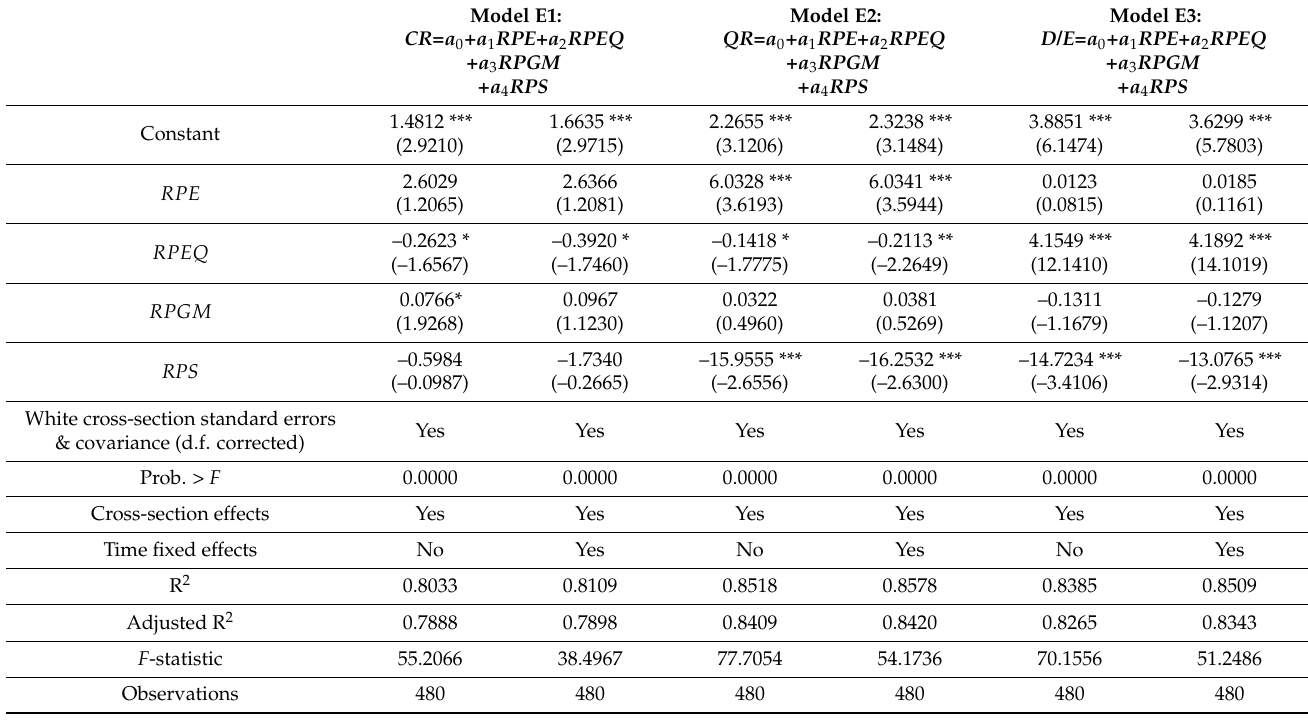
Table 10. Econometric models corresponding to the dependent variables CR , QR , and D/E for electricity